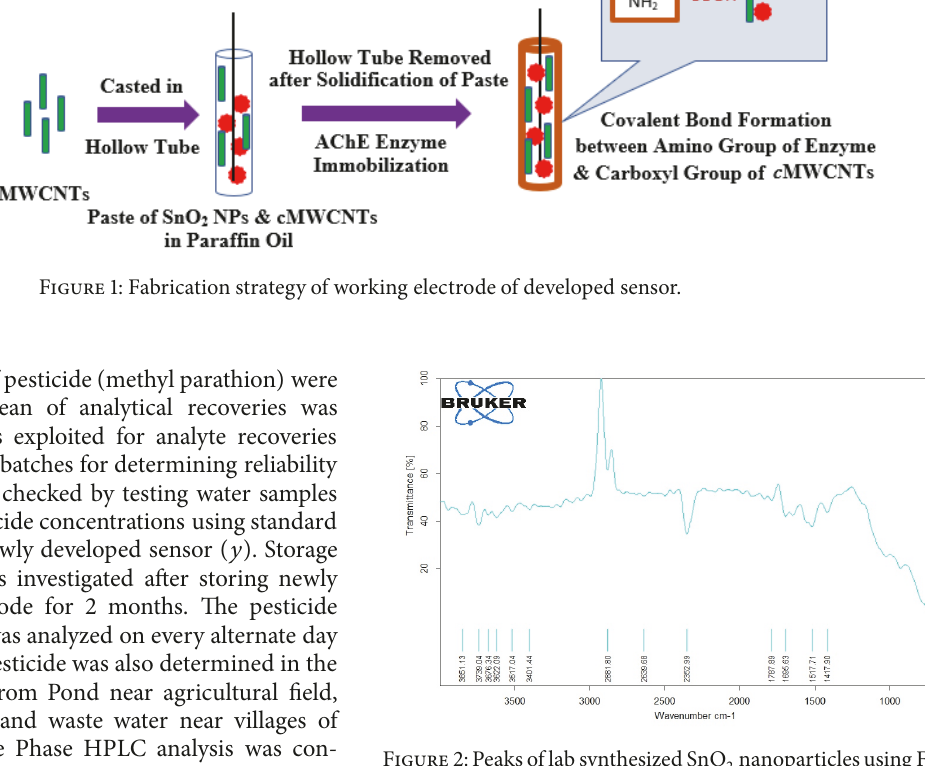
Figure 2:Peaks of lab synthesized SnO 2 nanoparticlesusing Fourier transform infrared spectroscopy.